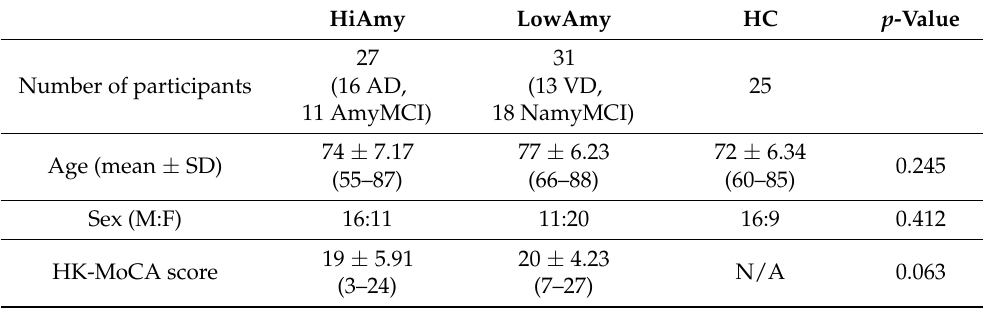
Table 1. Demographics of participants.